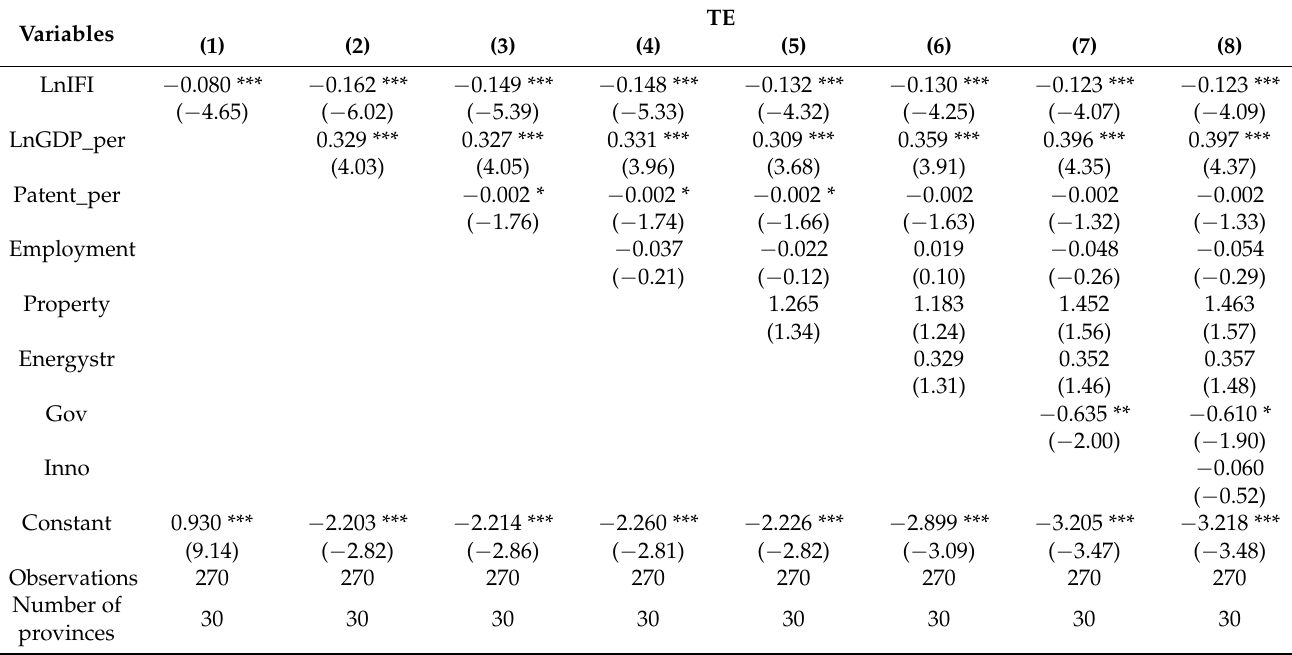
Table 6. Regression